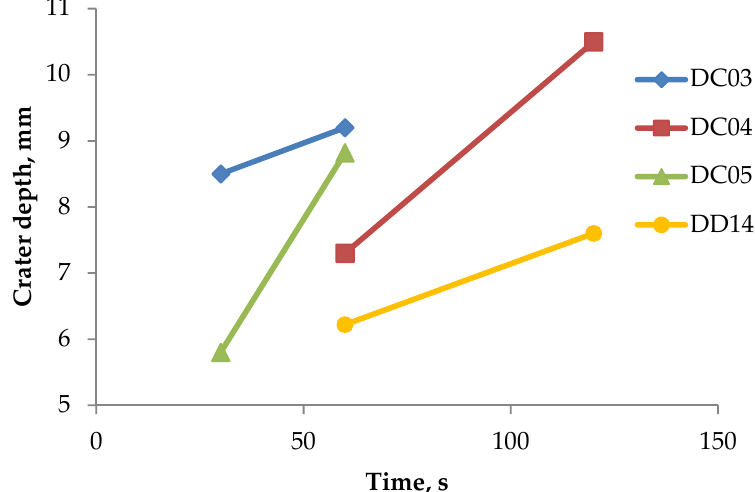
Figure 8. Crater depths in the investigated samples.